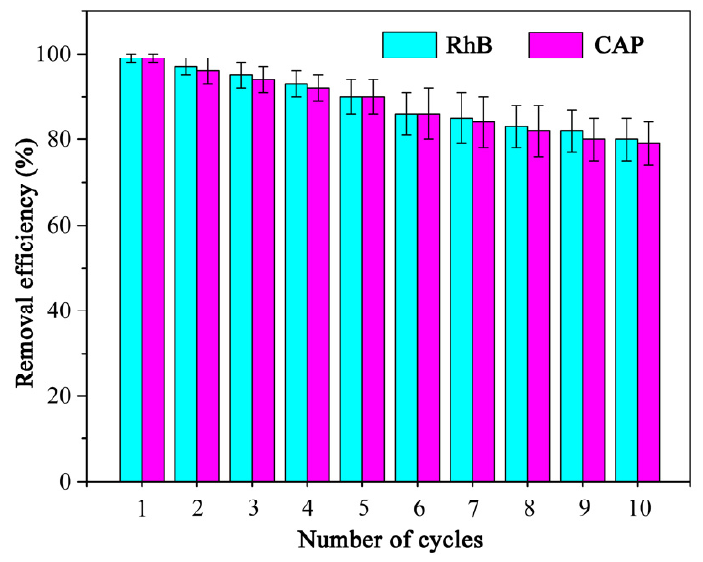
Figure 9. Reuse of PCAC for the adsorption of RhB and CAP. Conditions: adsorbent, 100 mg; solution volume, 100 mL; initial concentration, 50 mg L − 1 ; Temperature, 30 ◦ C. The pH values of RhB solutions were not adjusted.